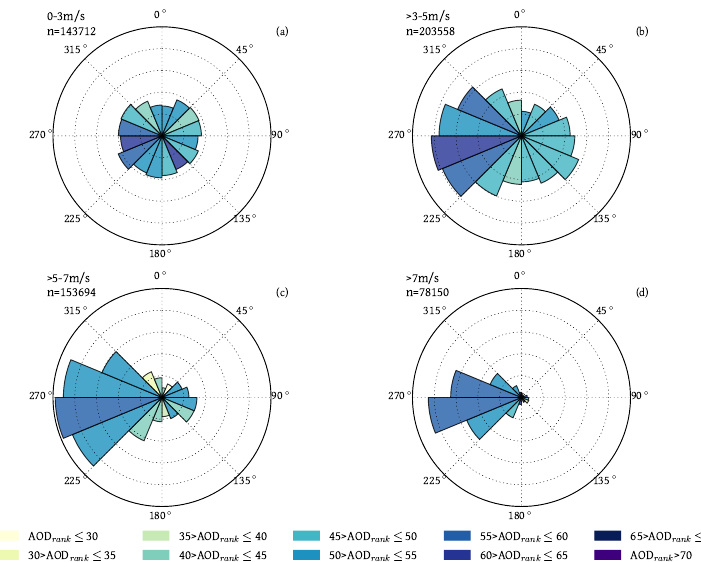
Figure 8. Relationship between AOD rank , wind direction and wind speed. Setup of figures ( a – d ) is identical to previous